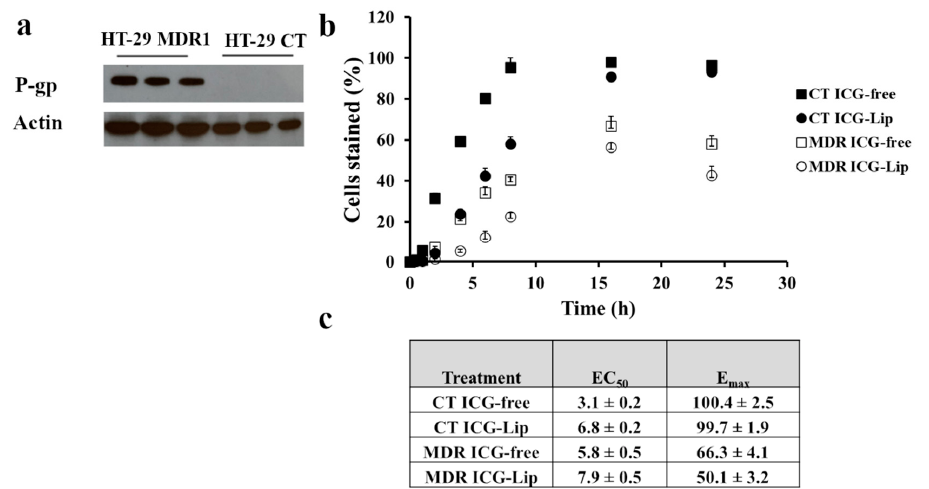
Figure 2. Characterization of P-gp in HT-29 CT and HT-29 MDR1 cell lines. ( a ). Western blot analysis of P-gp expression in HT-29 CT and HT-29 MDR1 cell lines. β -actin was used as the reference ( b ). FCS analysis of free ICG uptake or Lip-ICG, ( c ). EC50 and E max values derived from uptake profile of free ICG or Lip-ICG in HT-29 CT and HT-29 MDR1 cells, n = 3. Full and open markers represent non-irradiated and irradiated cells, respectively. Values represent mean ± SD.